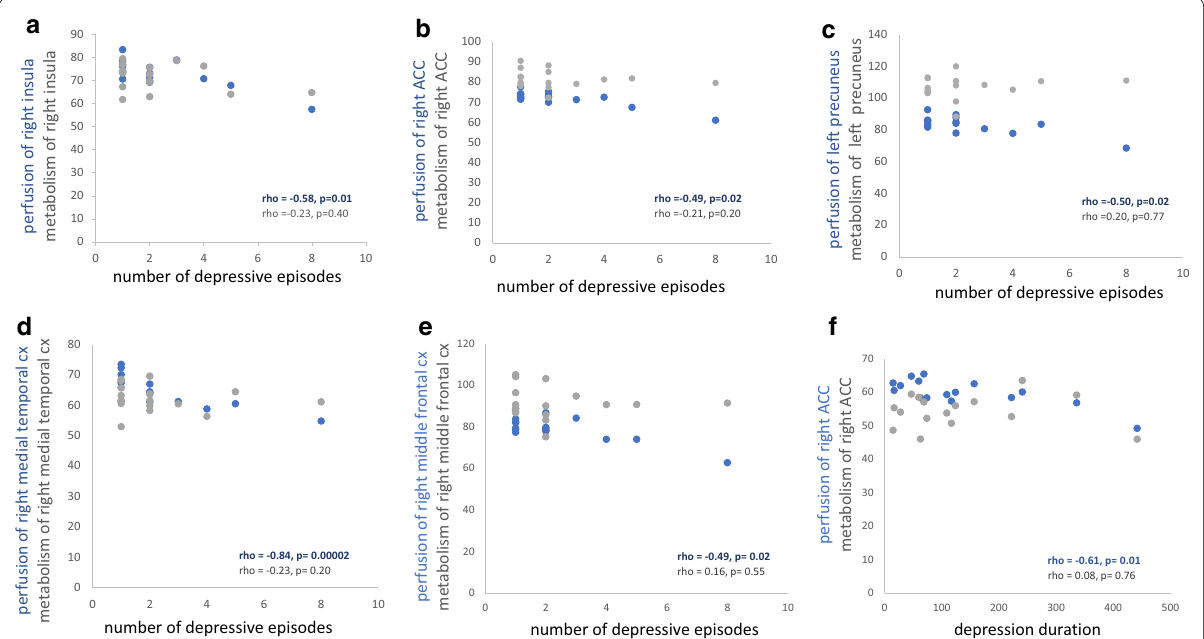
Fig. 2 Scatter plot of Spearman’s correlations on extracted clusters. The increased number of depressive episodes is correlated with decreased perfusion of: a the right insula (rho 0.58, p 0.01), b the right anterior cingulate cortex (ACC) (rho 0.49, p 0.02), c the left precuneus = − = = − = (rho 0.50, p 0.02), d the right medial temporal cortex (rho 0.84, p 0.00002) and e the right middle frontal cortex (rho 0.49, p 0.02). = − = = − = = − = This correlation is not significant with the metabolism of: a the right insula (rho 0.23, p 0.40), b the right ACC (rho 0.21, p 0.20), c the = − = = − = left precuneus (rho 0.20, p 0.77), d the right medial temporal cortex (rho 0.23, p 0.20) and e the right middle frontal cortex (rho 0.16, = = = − = = p 0.55). f The increased depression duration is correlated with decreased perfusion of the right ACC (rho 0.61, p 0.01). This correlation is not = = − = significant with the metabolism of the right ACC (rho 0.08, p = =